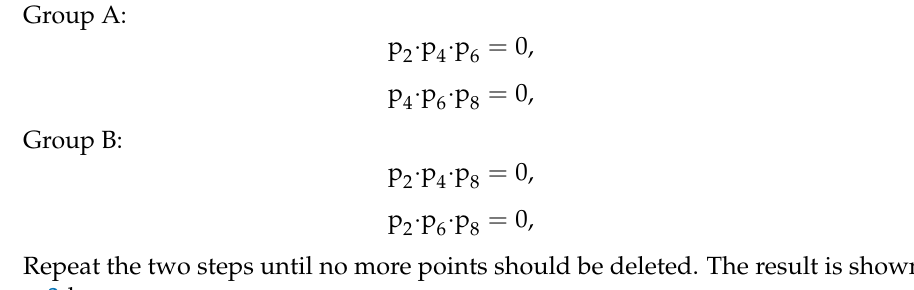
Figure 4. Arrangement of pixels in the operation of morphological thinning.